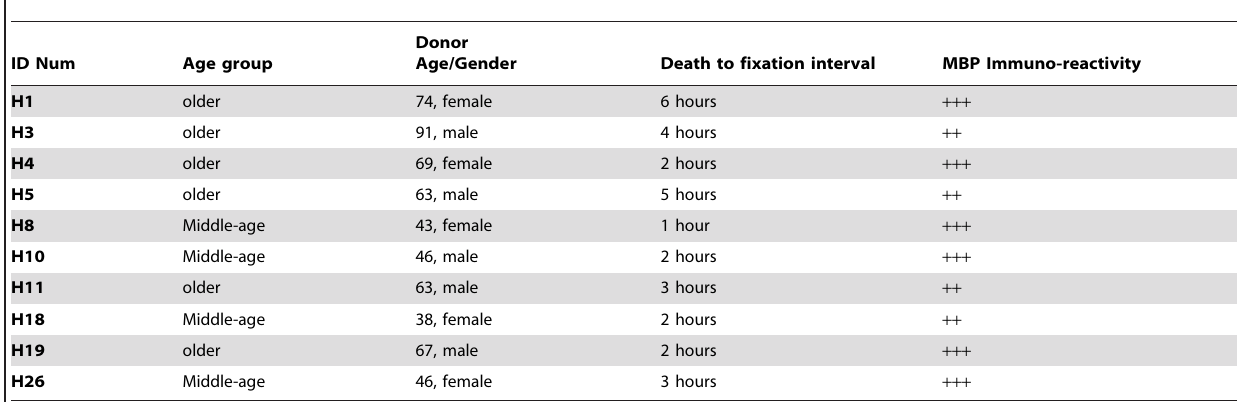
Table 1. Temporal bone donor information and immunoreactivity for MBP